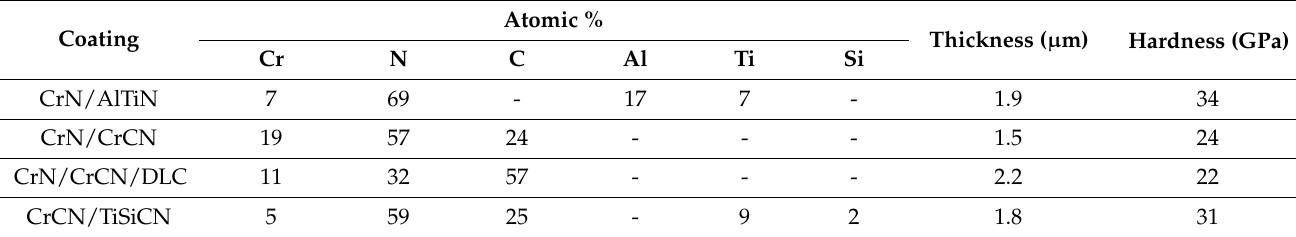
Table 4. Elemental composition and characteristics of coatings.